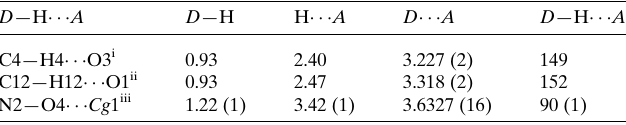
Table 1 Hydrogen-bond geometry (A˚ , (cid:3) ). Cg 1 is the centroid of the N1/C1–C4 ring.